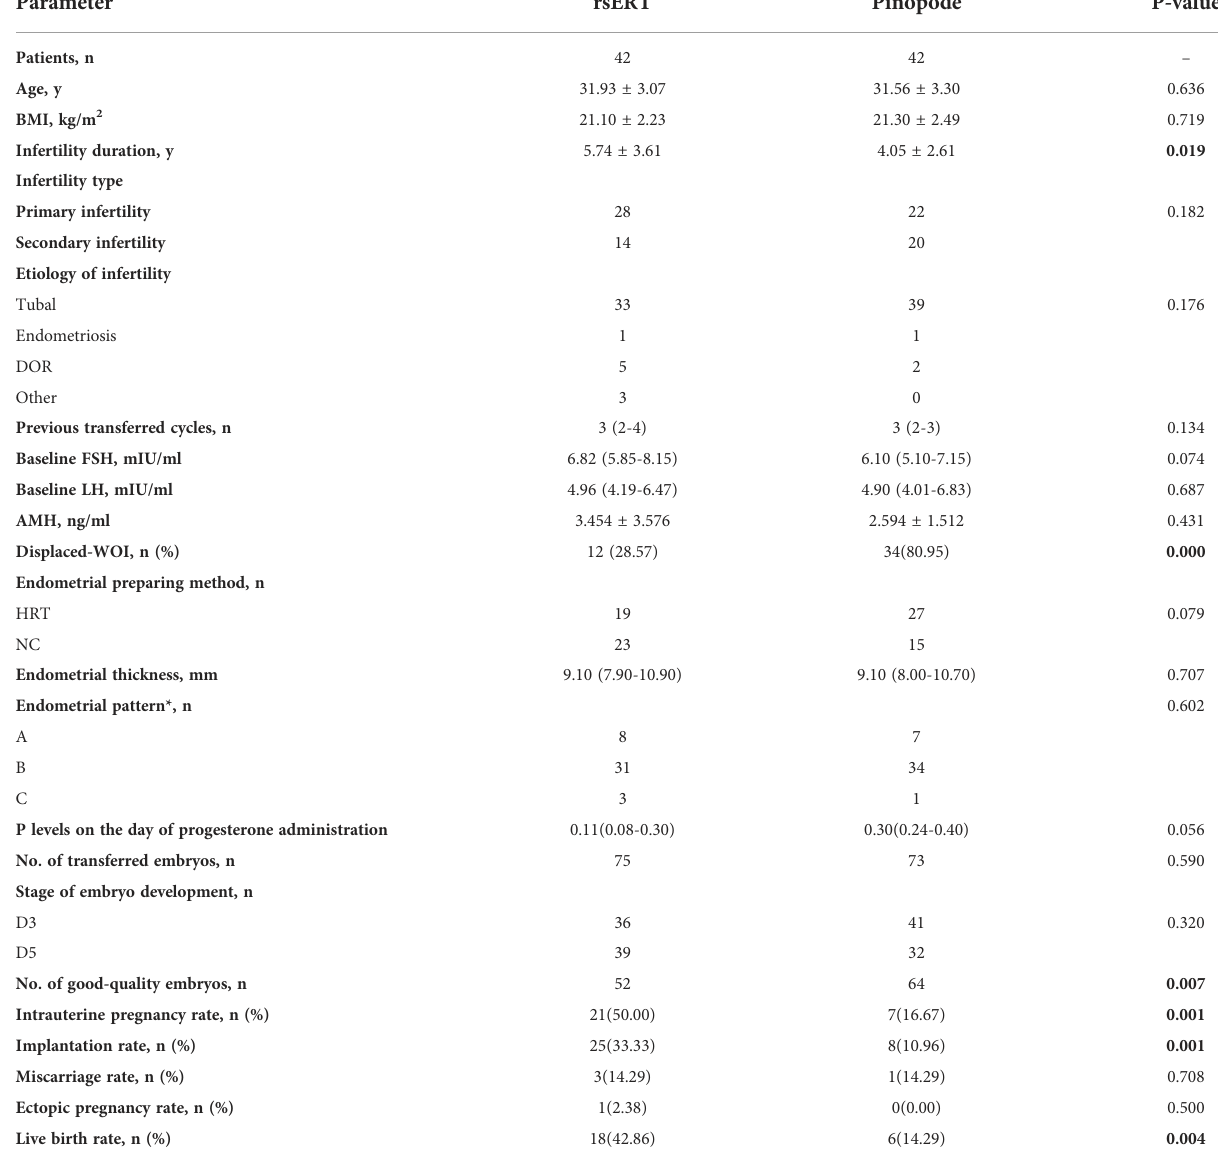
TABLE 2 Baseline information and clinical outcomes of patients that received pET (after